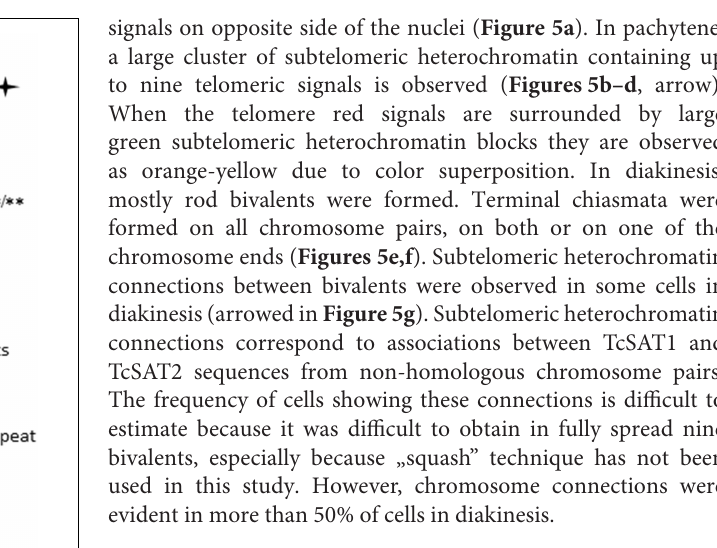
anther layers surrounding early meiocytes, Rabl configuration